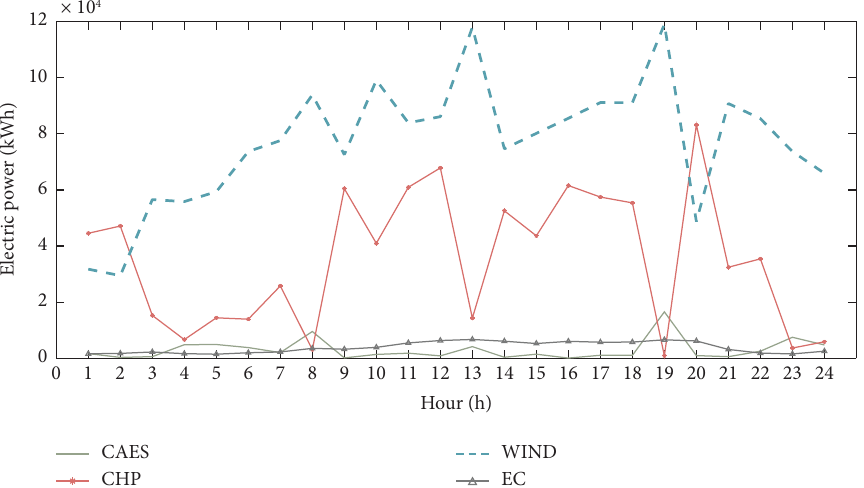
Figure 14: Power dispatch in summer.